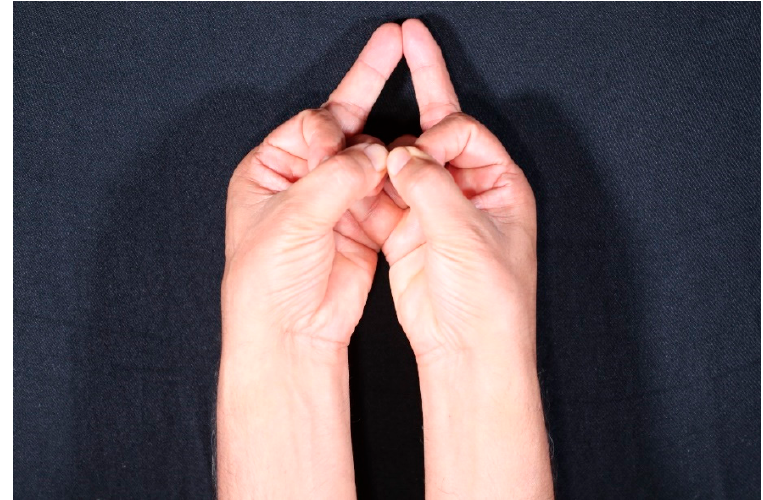
Religions 2021 , 12 , x FOR PEER REVIEW